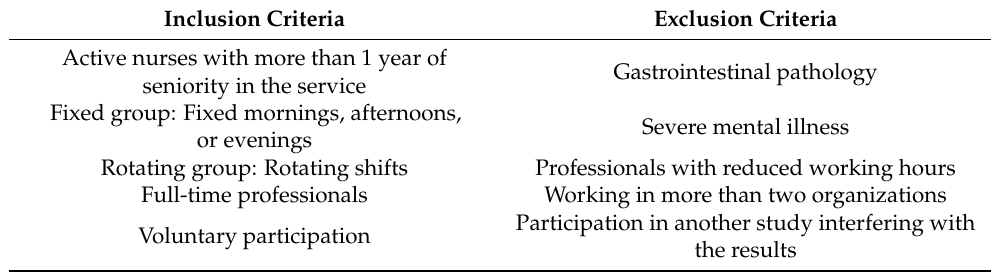
Table 1. Criteria for inclusion and exclusion of